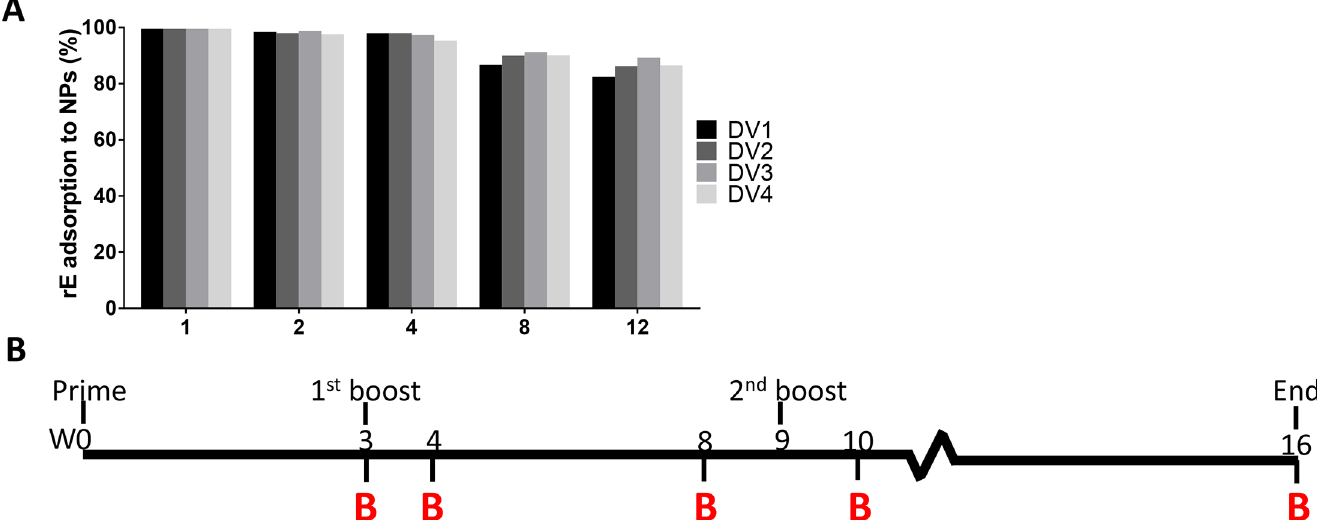
Fig 2. NP-rE adsorption efficiency. A ) rE proteins from all serotypes were individually adsorbed to the PLGA nanoparticles in variable srE/NP (w/w%) ratios. Adsorption efficiency was determined by the amount of non-adsorbed rE after the spinning down the particles. B) Mice were immunized (subcutaneous) with 5 μ g of rE or 5 μ g rE adsorbed to PLGA nanoparticles. Animals were boosted on day 21 and day 63 and serum samples were taken at indicated time